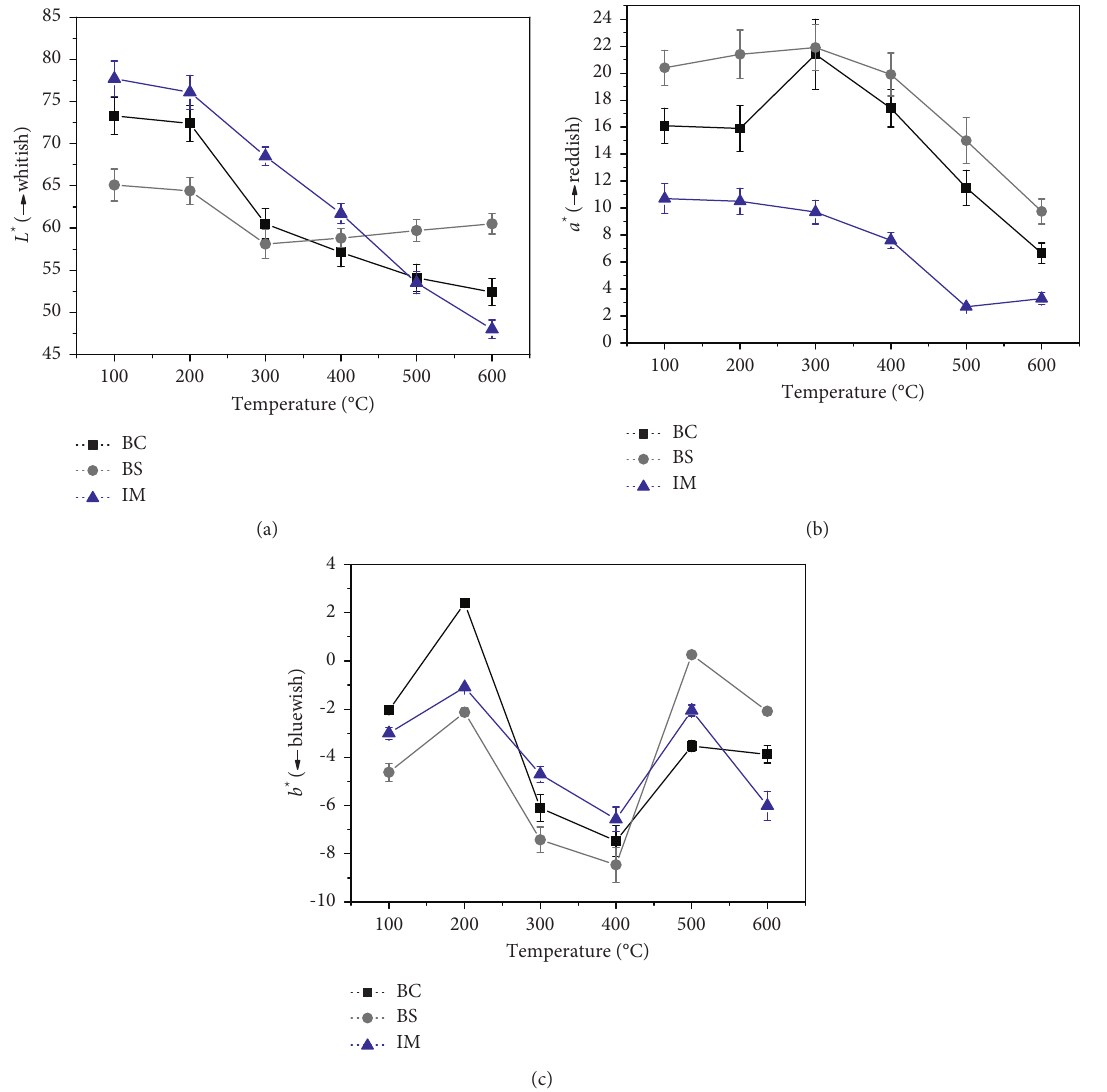
Figure 7: Variations of L ∗ a ∗ b ∗ color values as a function of thermal treatment for three types of rocks: (a) L ∗ , (b) a ∗ , and (c) b ∗